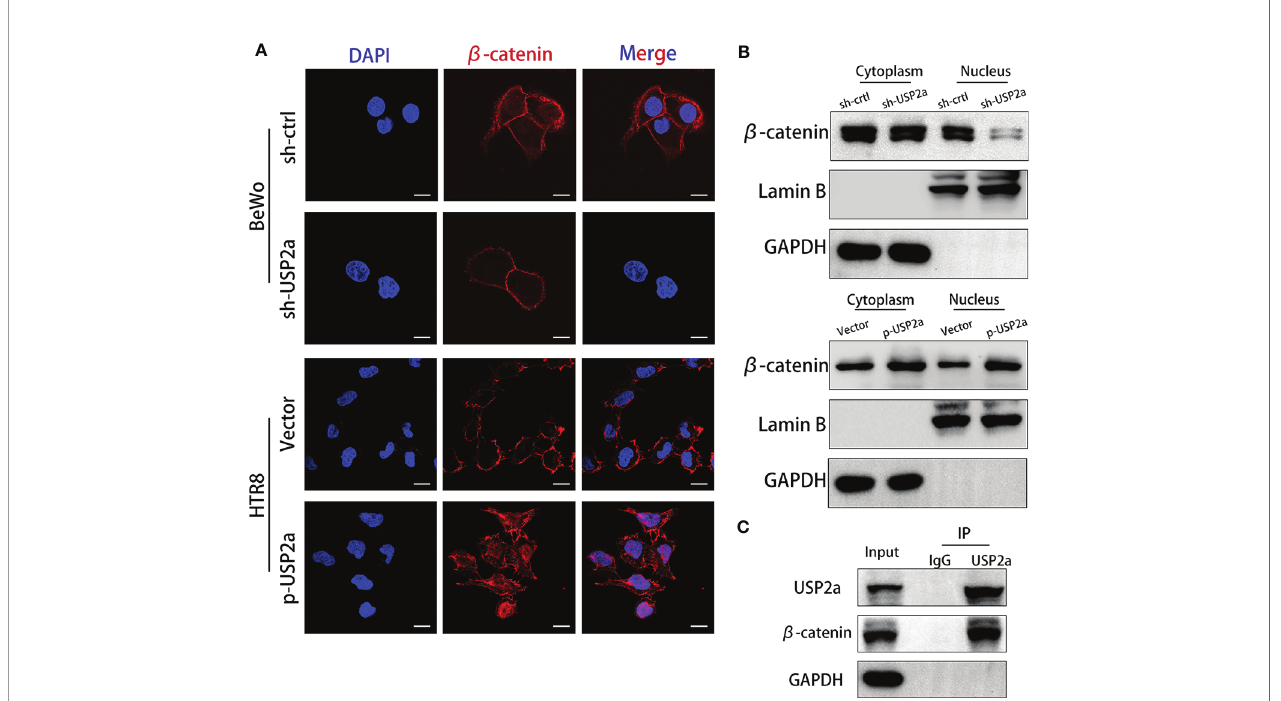
FIGURE 4 | Reduced USP2a Expression impairs nucleocytoplasmic translocation of b -catenin. Knockdown of USP2a attenuates nuclear translocation of b -catenin in BeWo cells. Overexpression of USP2a induces nuclear translocation of b -catenin in HTR8 cells BeWo cells were transfected with sh-Ctrl or sh-USP2a, and HTR8 cells were transfected with p-USP2a or vector. Both cells were cultured for 48 hours. (A) The cells were seeded to immuno fl uorescent staining for b -catenin (red) and counterstained with DAPI (blue) to assess the subcellular localization of b -catenin and (B) western blot was performed to compare the levels of b -catenin in the nucleus and cytoplasm. GAPDH and lamin B were used as the loading control. (C) Co-IP assays of the interaction between USP2a and b -catenin in HTR8. Scale bar = 10 m